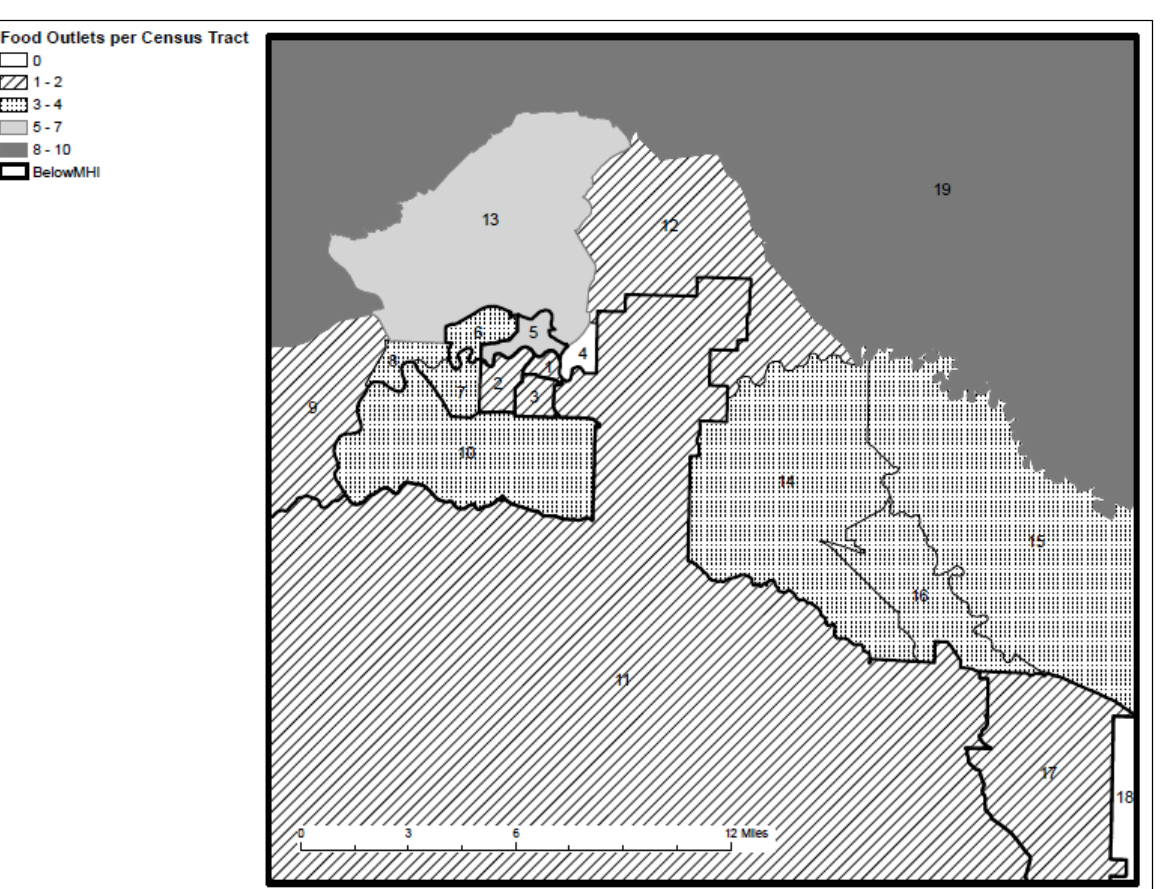
Figure 3. Stores per Census Tract in Fairbanks